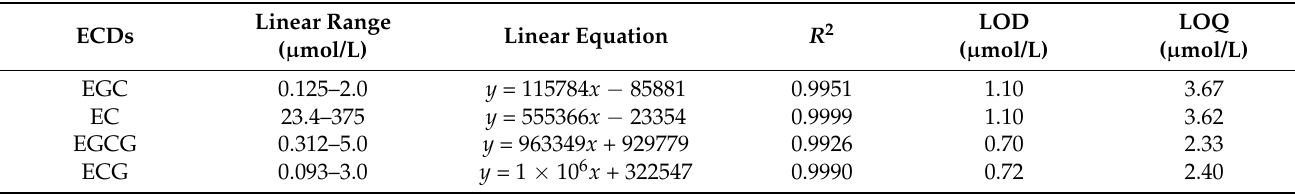
Figure 1. HPLC chromatogram (UV at 280 nm) of the ethyl acetate extract of commercial green tea sample of Azorean C. sinensis var. sinensis from Gorreana Tea Plantation. Peaks: GC—gallocatechin; EGC—epigallocatechin; CAF—caffeine; C—catechin; EC—epicatechin; EGCG—epigallocatechin-3-gallate; GCG—gallocatechin-3-gallate; ECG—epicatechin-3-gallate. Analytical chromatographic conditions are referred to in Methods. Table 2. The linear range, regression equations, and the limits of detection and quantification of the major catechins derivatives